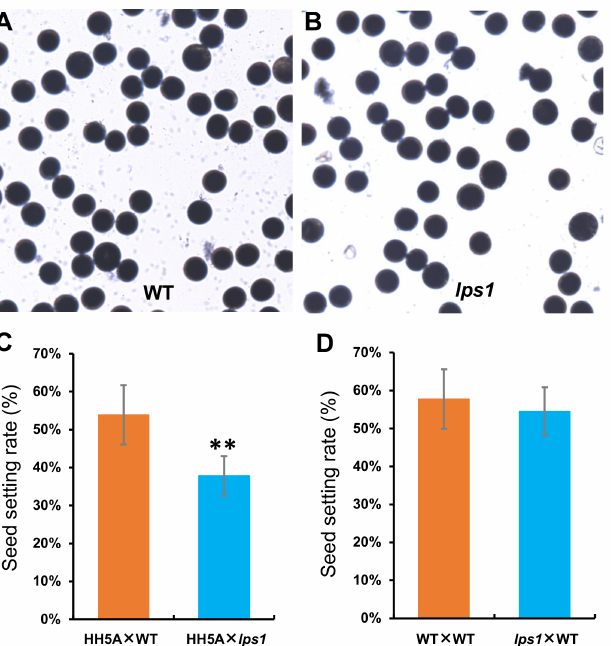
Figure 9. Detection of male and female fertility of lps1 mutant. ( A , B ) Pollen grains of the wild type and lps1 were stained with I 2 -KI solution, respectively. ( C ) The wild type and lps1 were used as pollen donors and crossed with cytoplasmic male sterile line Huihe 5A (HH5A), respectively. ( D ) The wild type and lps1 were artificially emasculated and then were pollinated by using the other normal wild-type plants, respectively. Error bars represent standard deviations of three independent biological replicates. The statistically significant differences were performed by Student’s t test. ** p <